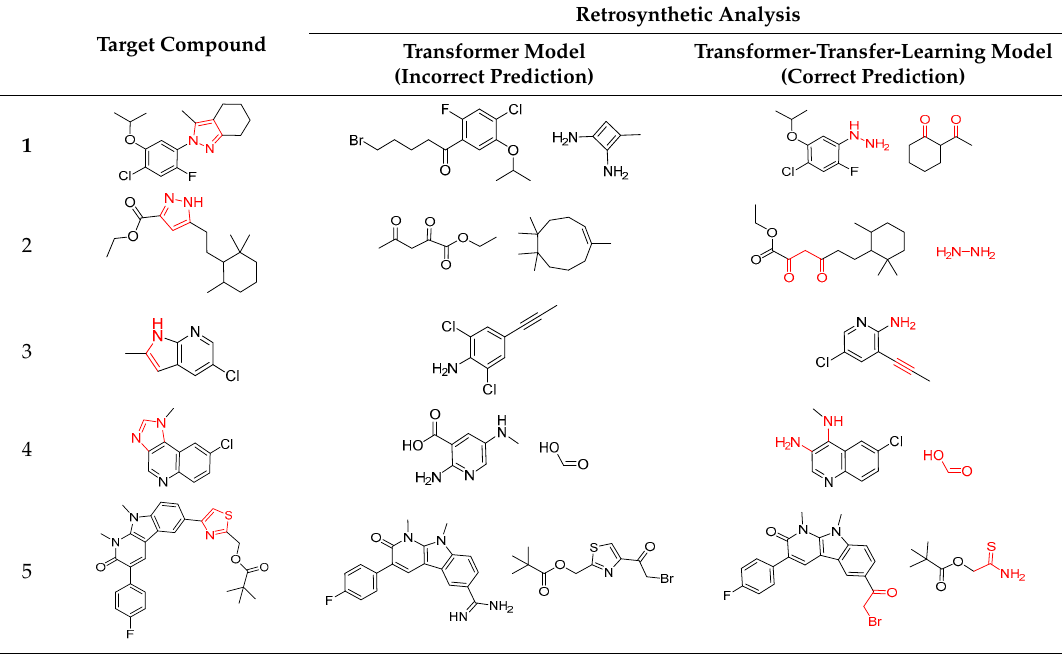
Table 5. Comparisons and representative examples (selected from the test set) of the Transformer and Transformer-transfer-learning models in the retrosynthetic prediction of heterocycle formation reactions.